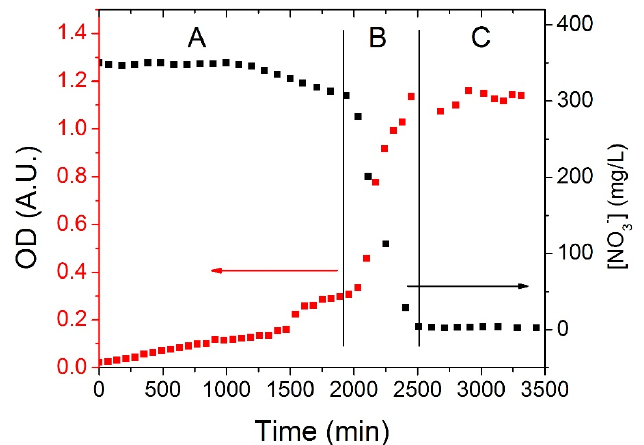
Figure 3. Experimental curves of nitrates reduction operated by the azospira OGA 24. Black squares represent nitrates concentration over time, measured by means of the NO 3 − ISE; red squares show the increase of the solution optical density over time, i.e. , the growth of the bacteria population. Three different regions can be identified: A : acclimation zone; B : exponential consumption of nitrates (increase of the bacterial population); C : steady